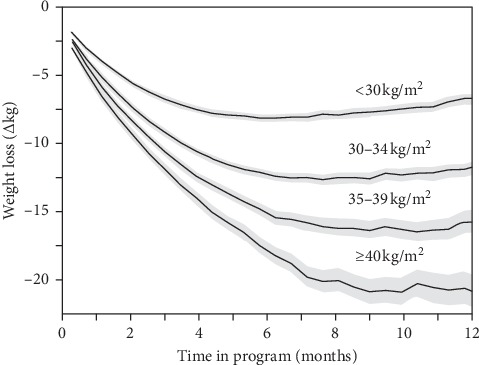
Change in weight (∆kg) over time by baseline BMI. There were 9525 healthy or overweight patients (<30 kg/m2), 6776 class I obese patients (30–34 kg/m2), 3295 class II obese patients (35–39 kg/m2), and 2043 class III obese patients (≥40 kg/m2) at baseline.